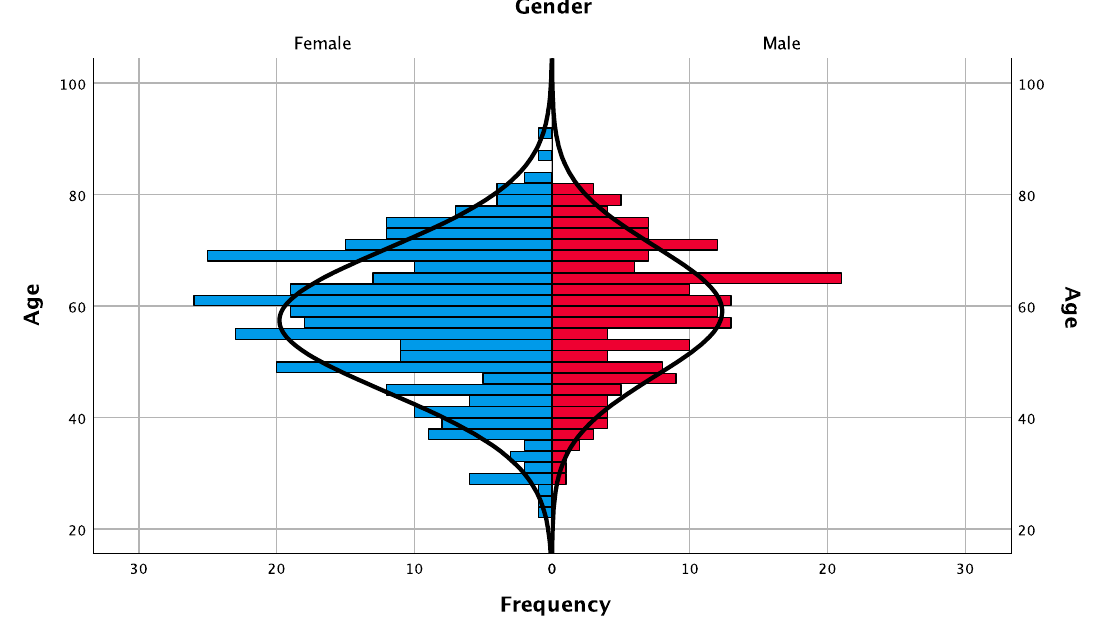
Figure 1. Demographic pyramid of the frequency distribution of patients according to gender and age. Table 2. Implant-based analysis in each implant group ( n = implant).